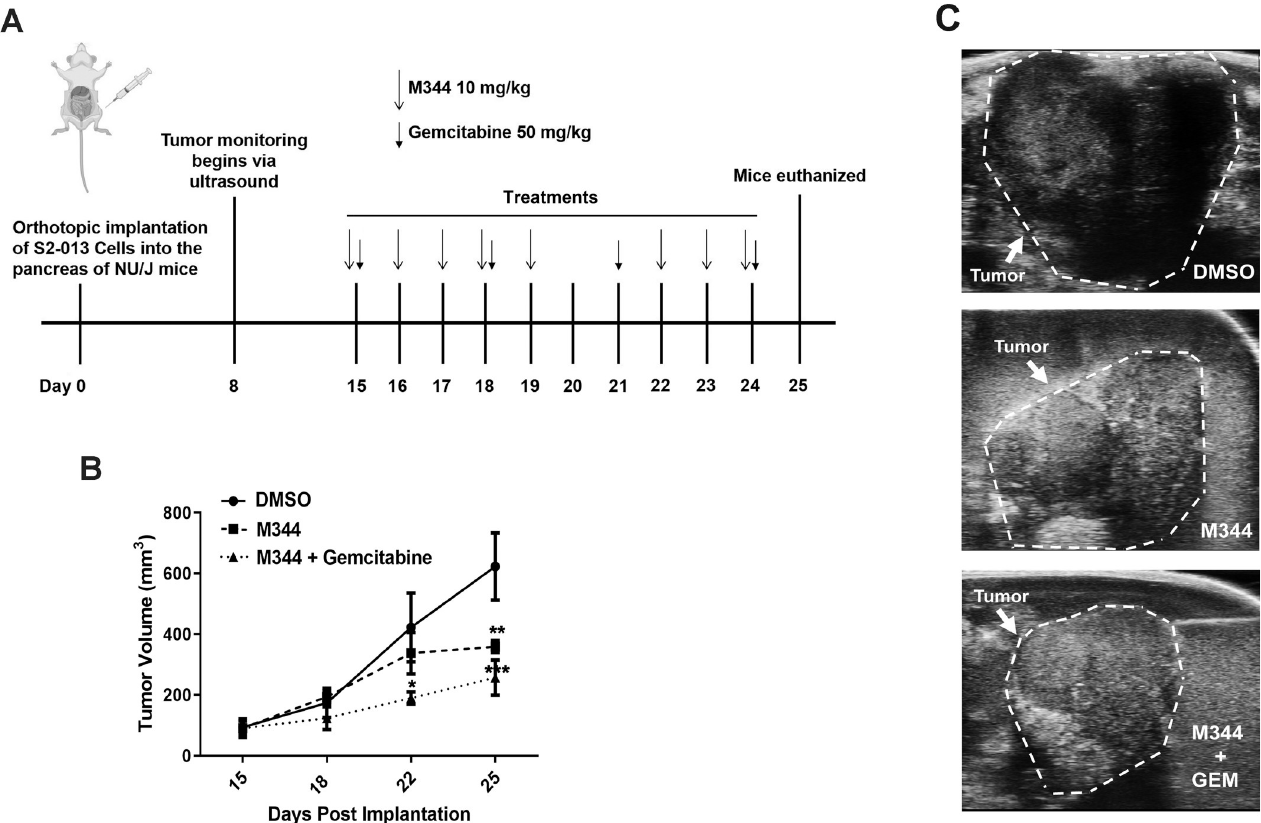
Fig 13. M344 decreases orthotopic pancreatic tumor growth when used as a treatment alone or in combination with gemcitabine. ( A ) S2-013 cells were orthotopically implanted into the pancreas of female NU/J mice. After 8 days, the tumor volume for each mouse was monitored twice weekly with the VisualSonic Vevo 3100 Imaging System. At 15 days post-implantation of tumor cells, the mice were randomized into control or treatment groups with matched average tumor volumes. M344 was administered intraperitoneally at 10 mg/kg for 5 days per week (5 days on, 2 days off). Gemcitabine was given every 3 days intraperitoneally at 50 mg/kg. On Day 25 post-tumor implantation, the mice were euthanized and the tumors were resected and weighed. The changes in tumor volume over time are shown in ( B ) and representative images of tumors at 25 days post implantation are shown in ( C ). For statistical analysis, ordinary One-way ANOVA with Dunnett’s Multiple Comparisons test in GraphPad Prism Version 8.4.2 was used. The asterisks indicate the following p values: � p < 0.05, �� p < 0.01, ��� p <